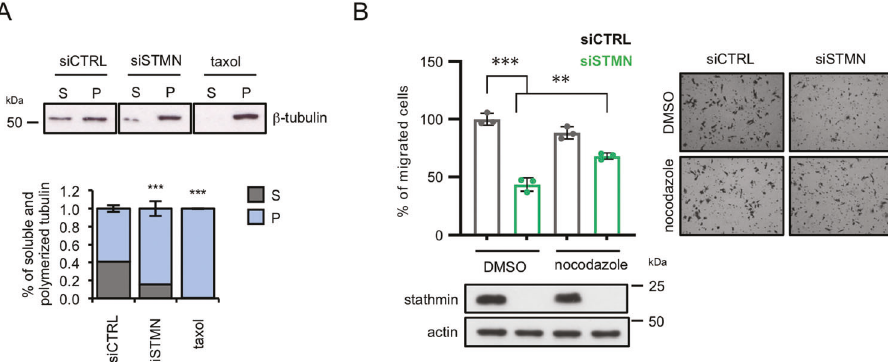
Fig. 2 Stathmin regulates cell migration through microtubule modulation. A Western blot analysis of tubulin protein levels in soluble- tubulin (S) and polymerized-tubulin (P) fractions after microtubule separation assay performed in MDA-MB-231 cells silenced for stathmin expression (siSTMN), control (siCTRL), or taxol (a drug that stabilizes microtubules counteracting their disassembling) as positive control of tubulin polymerization. Densitometry analysis of tubulin expression (normalized on total tubulin amount of each sample) is reported in the bottom graphs and presented as the mean (±SD) of n = 3 replicates. B Quanti fi cation of the trans-well migration assay performed in MDA-MB- 231 cells upon silencing of stathmin (siSTMN) and 1 h of nocodazole treatment. The results are presented as the mean of the percentage of migrated cells with respect to control ( n = 3). Representative pictures are shown on the right of the graph. Stathmin western blot analyses are reported at the